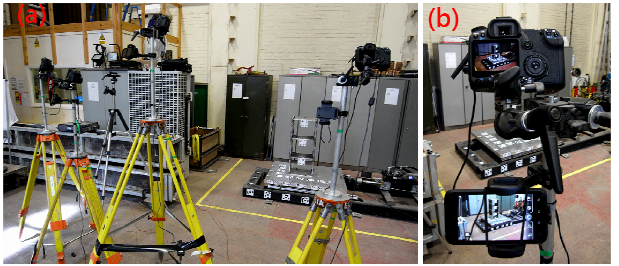
Figure 3: (a) Experimental configuration. (b) A close-up photograph of an individual image station; the mobile phones were mounted on customized tripod